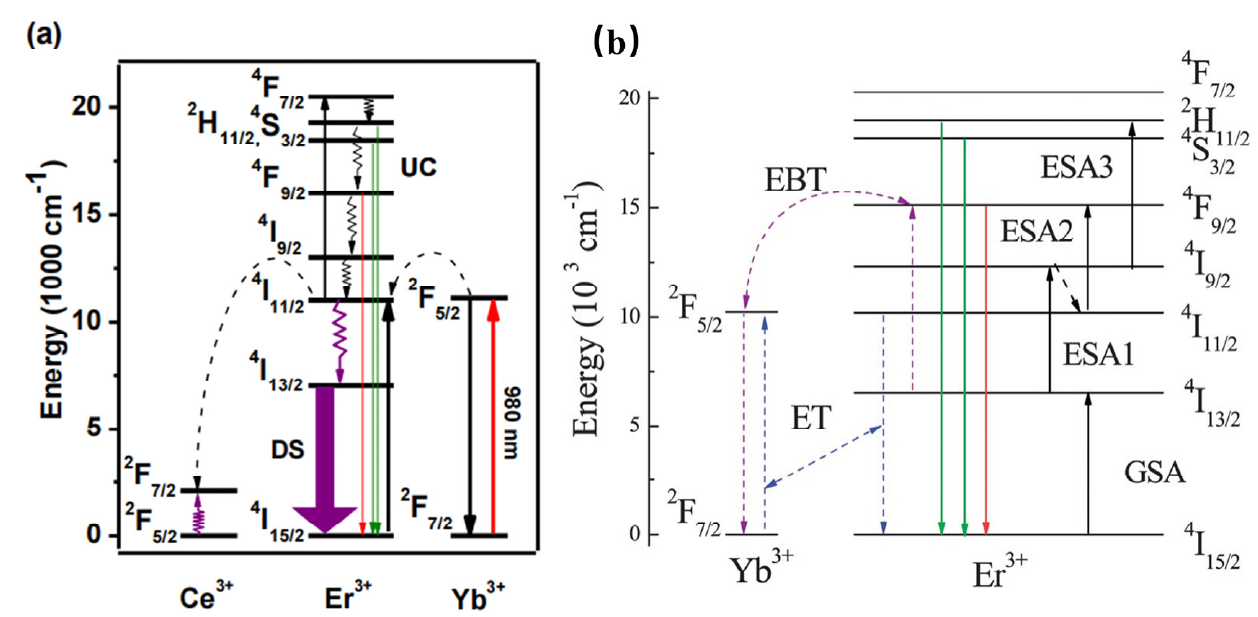
Figure 4. ( a ) Schematic mechanism for the energy-transfer process in the UC emission of Er 3+ ions. ( b ) Energy-level diagram for Er 3+ and Yb 3+ ions.